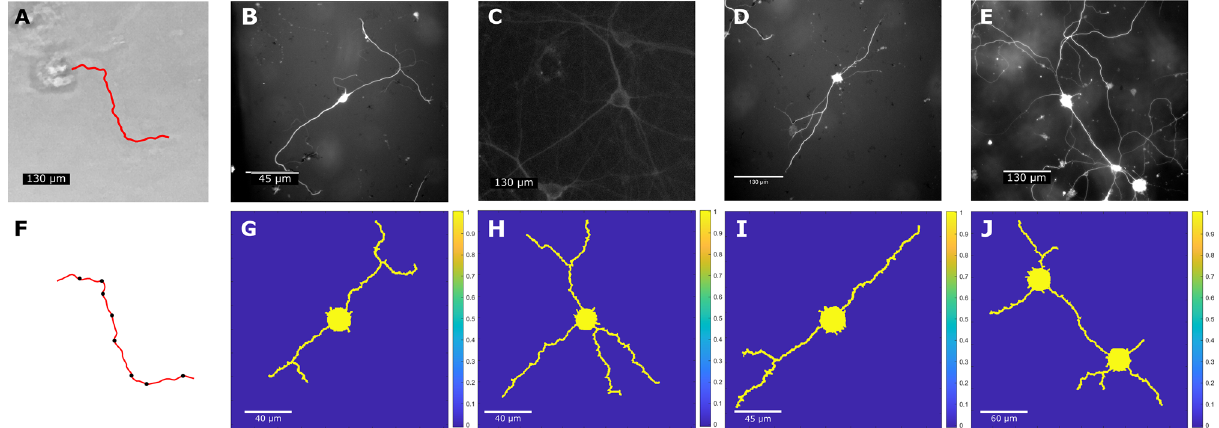
Figure 4. Comparison of the phase field model results of neuron growth with experimental results based on extracellular attractive cue-guided growth. ( A ) Traced neurite (red line) from a neuron cell culture at 5 DIV. ( F ) Change points (black dots) found along the neurite tracing (red line) in ( B ) using CPT algorithm with α of 0.05 and q of 2. ( B – E ) Experimental images of primary rat hippocampal neurons observed at 20 DIV. ( G – J ) Corresponding simulation results of phase field model using attractive cue-guided neuron growth on grid sizes of 443 Œ 443, 513 Œ 513, 483 × 483, and 483 Œ 483. One extracellular cue is placed at the boundary for each neurite. Bifurcation is achieved by adding more than one extracellular cue at the corresponding growth stage.